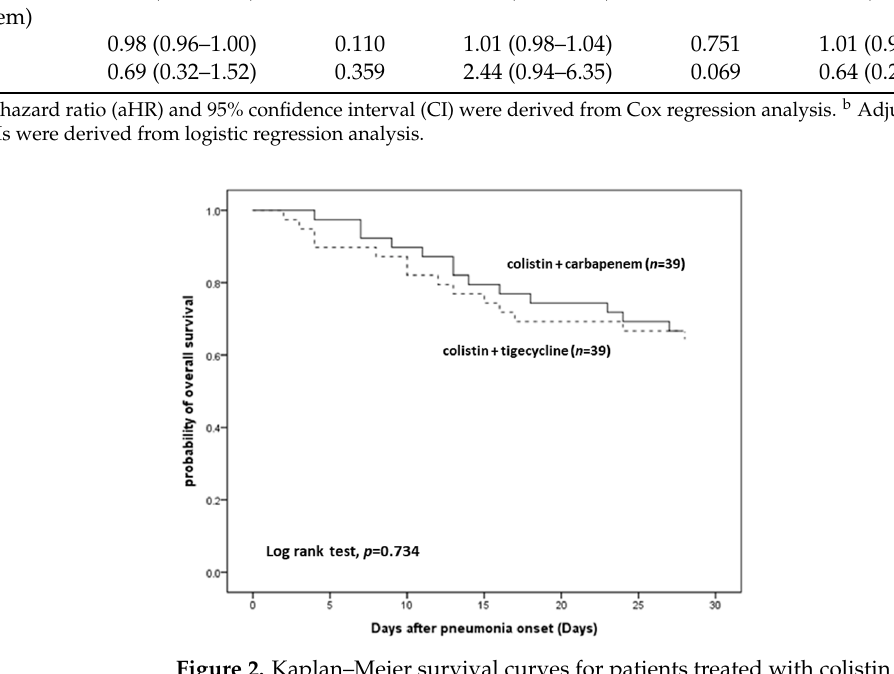
Figure 2. Kaplan–Meier survival curves for patients treated with colistin + carbapenem or colistin + tigecycline after propensity score matching.